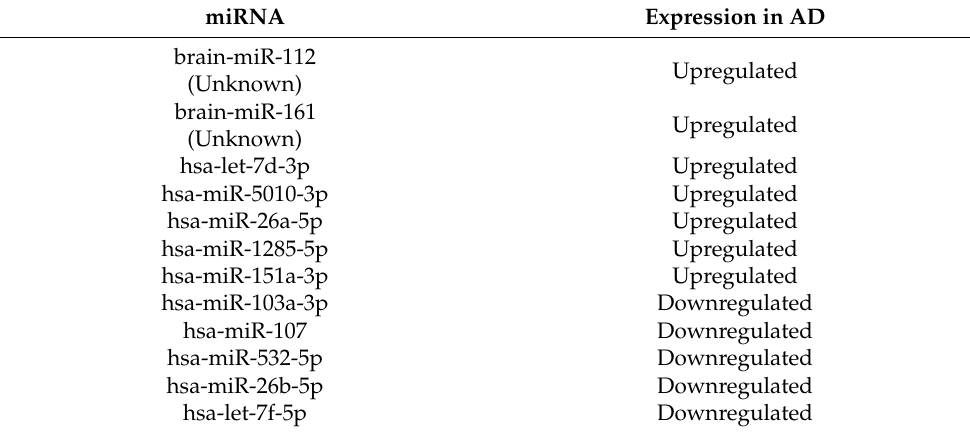
Table 1. Suggested circulating miRNA profiles specific for AD, detected in blood (Adapted from Leidinger and collaborators [63]).